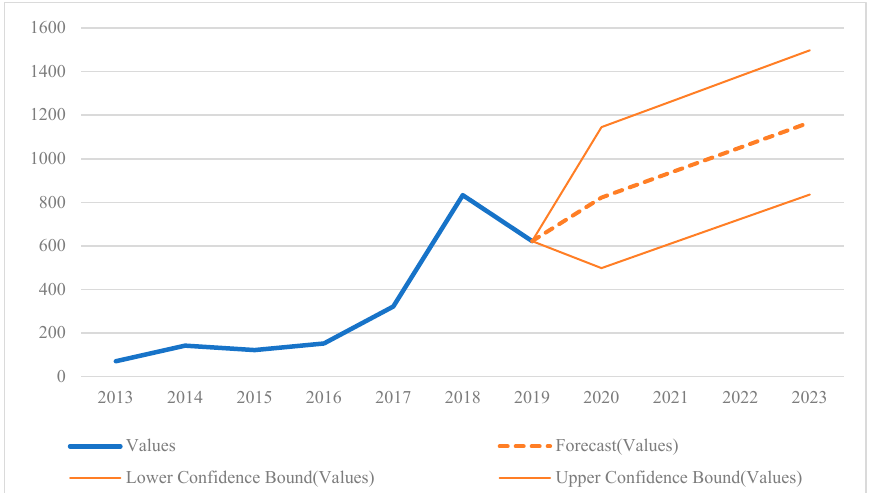
Figure 12. Number of deals by venture capital firms in blockchain technology and future deal count forecasts. Source: Calculated by the authors using CB insights, Hutt Capital, PwC, ICO Insights and Token Data.